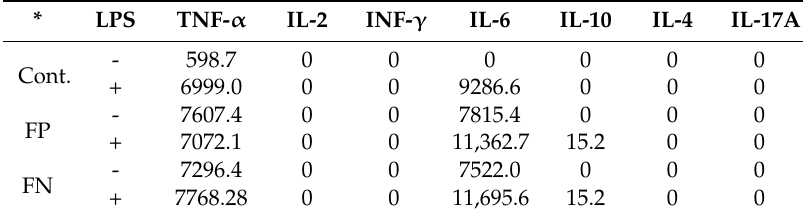
Table 3. Results of the cytokine production assay (identification of TNF- α , IL-2, INF- γ , IL-6, IL-10, IL-4, and IL-17A) on macrophages incubated with 0.001 mg/mL FP or FN.